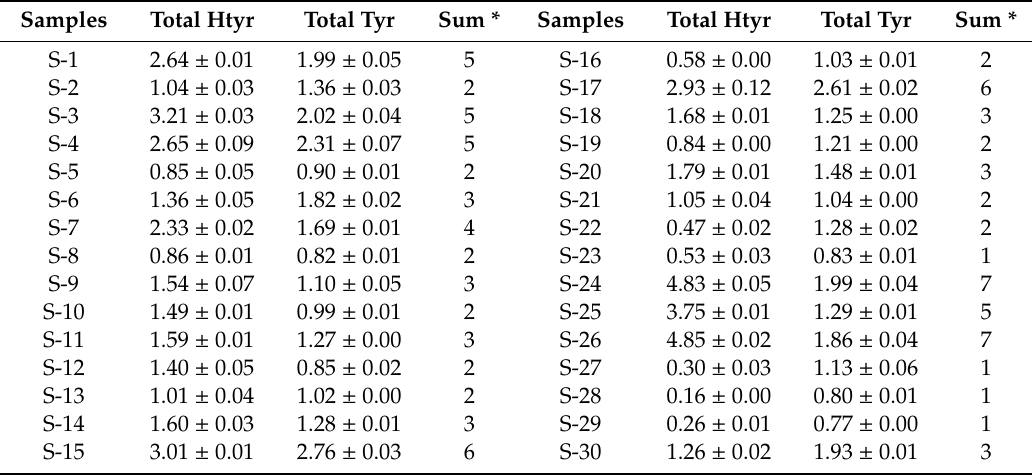
Table 3. Total (free and bound forms) Htyr and Tyr content (mg / 20 g oil) of VOO samples according to protocol